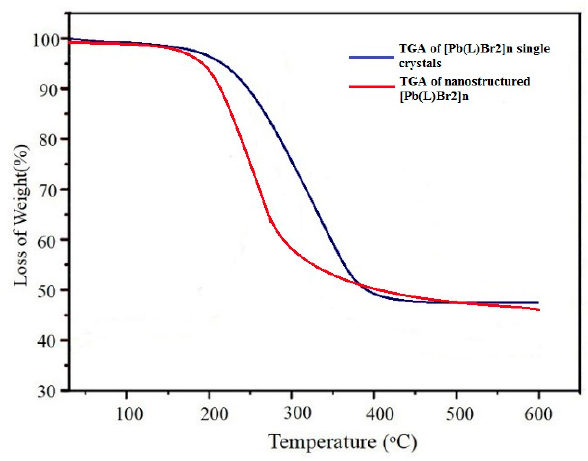
Figure 5. TGA plot of [Pb(L)Br 2 ] n ( 1 ) in single crystal shape and nanostructured mode.